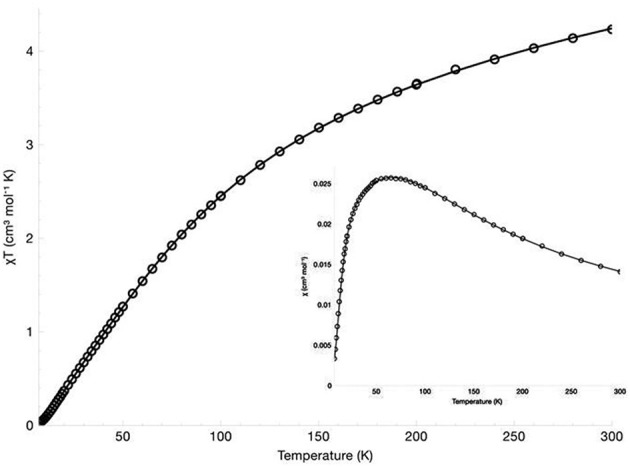
χM vs. T, and χMT vs. T (insert) plots for [Co2(L1)(μ-OAc)](ClO4)2·0.5H2O.